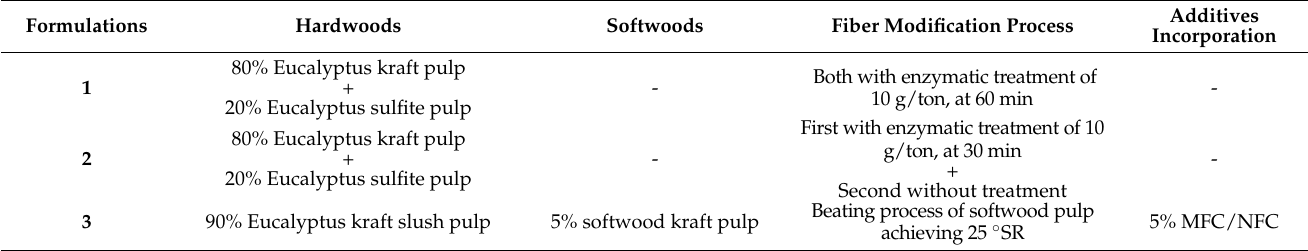
Table 1. Examples of case studies of different furnish scenarios to design new multi-structured innovative tissue paper materials.